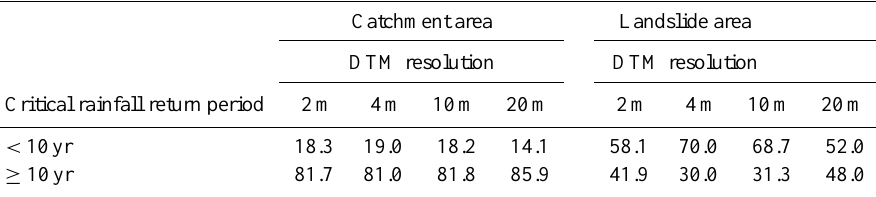
Table 4. Percentages of slope-stability categories in terms of catchment area and of observed landslide area in two main ranges of critical rainfall frequency (return period) for the QD-SLaM application and for the DTM resolution of 2, 4, 10, and